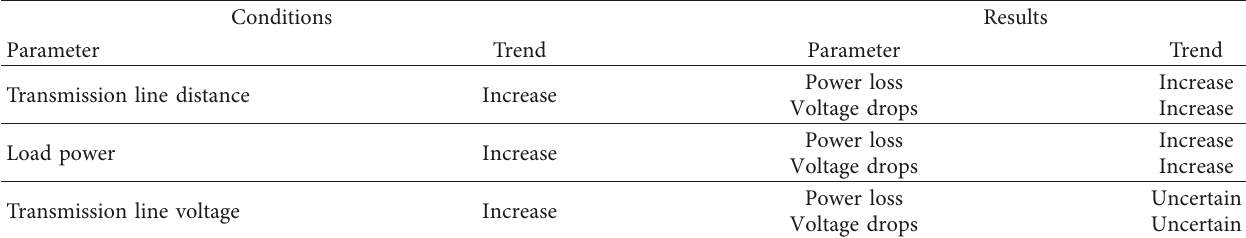
Table 7: Summary of the results of the experiment according to the